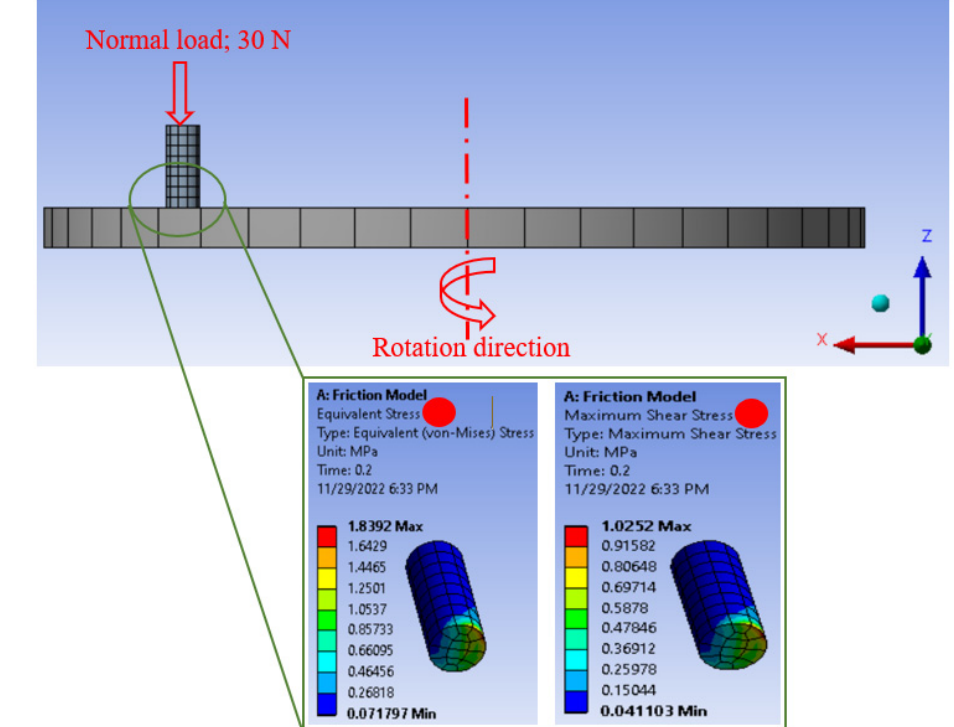
Figure 11. FEM of the friction process and the distributed contact stresses on Mg/TiO 2 composite surface.